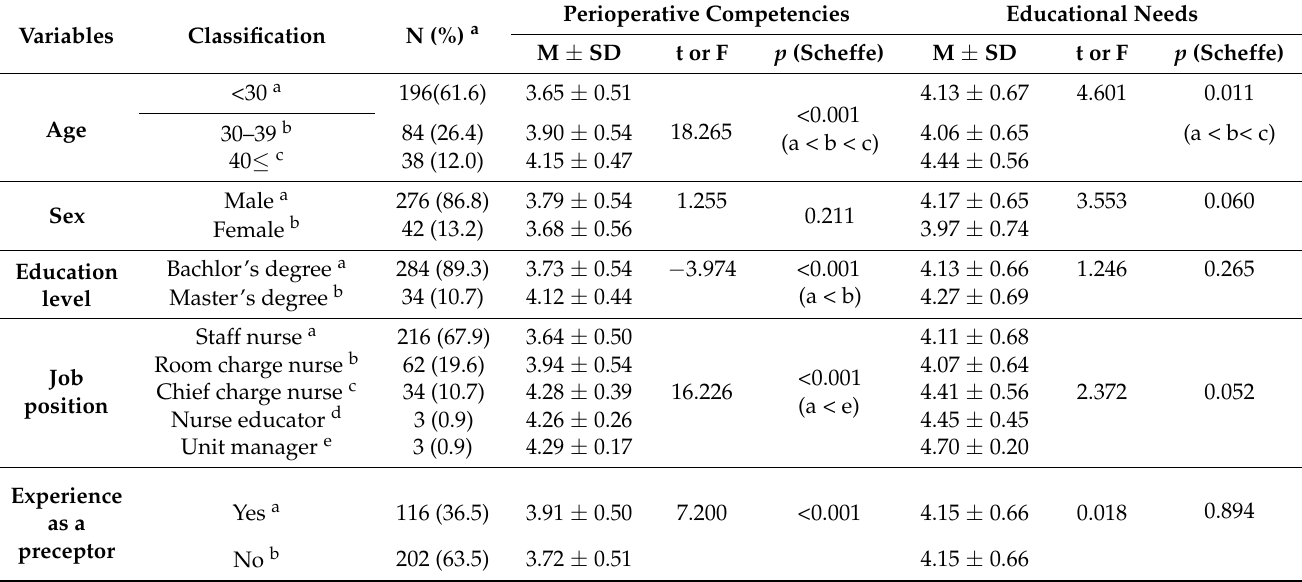
Table 1. Difference in perioperative competencies and educational needs by demographic characteristics.